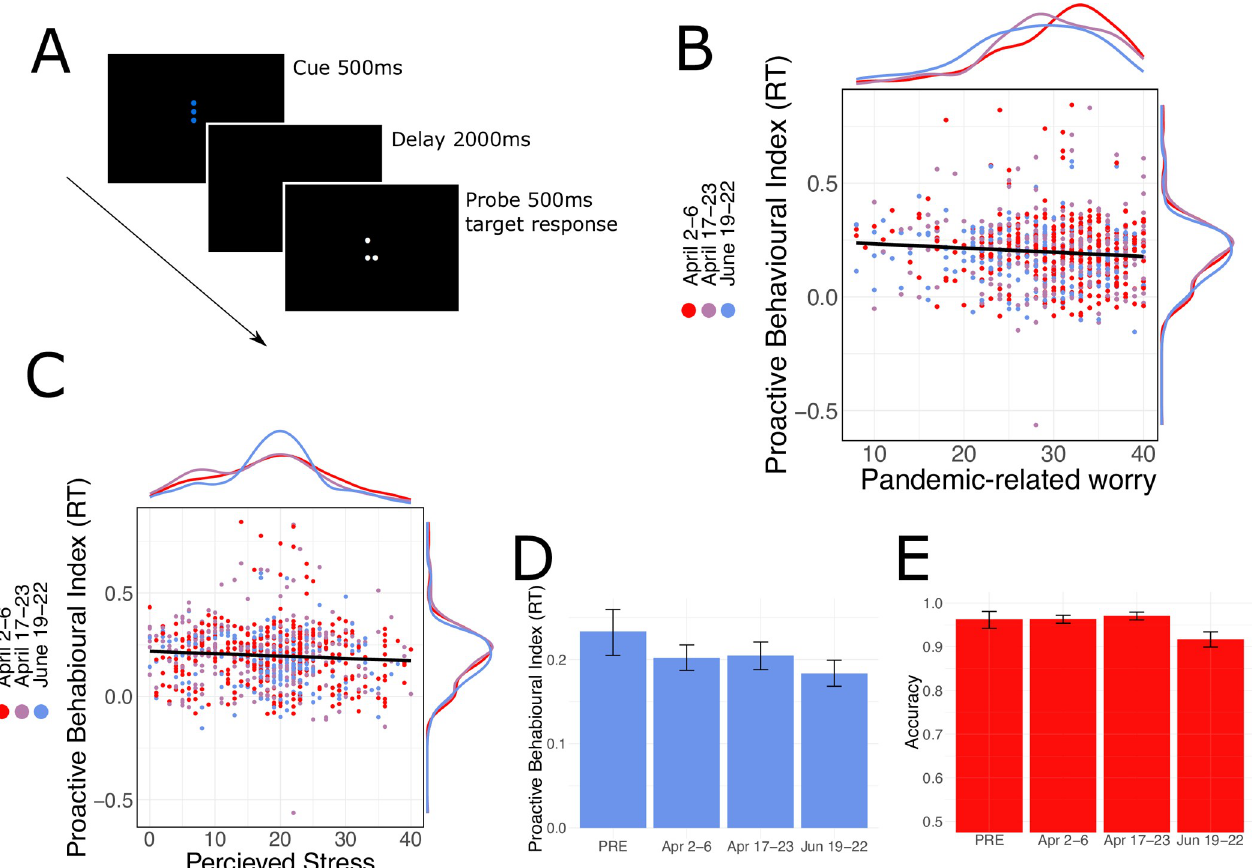
Fig 4. Participants’ performance on the dot pattern expectancy task. A. Schematic of the dot pattern expectancy task where a specific combination of cue (shown in blue) and probe (shown in white) dots were deemed to be the “target” stimulus and associated with target responses, all other combinations required non-target responses. B. We observed a negative relationship between FCQ scores PBI ( β = -0.0020, CI = [-0.0034, -0.0005], p = .010); here plotted with marginal distributions for the ordinate and abscissa. C. We observed a negative relationship between perceived stress scores and PBI ( β = -0.0108, CI = [-0.0200 –-0.0015], p = .023); again, with marginal distributions plotted for the ordinate and abscissa. D . Proactive behavioural index (PBI) decreased in comparison to the pre-pandemic sample ( β = -0.0353, CI = -[-0.0674, -0.0032], p = .031) but not with pandemic progression (p’s > .20); error bars represent the 95% bootstrap confidence interval. E. Overall accuracy was not found to decrease as a function of pandemic progression (p > .05).